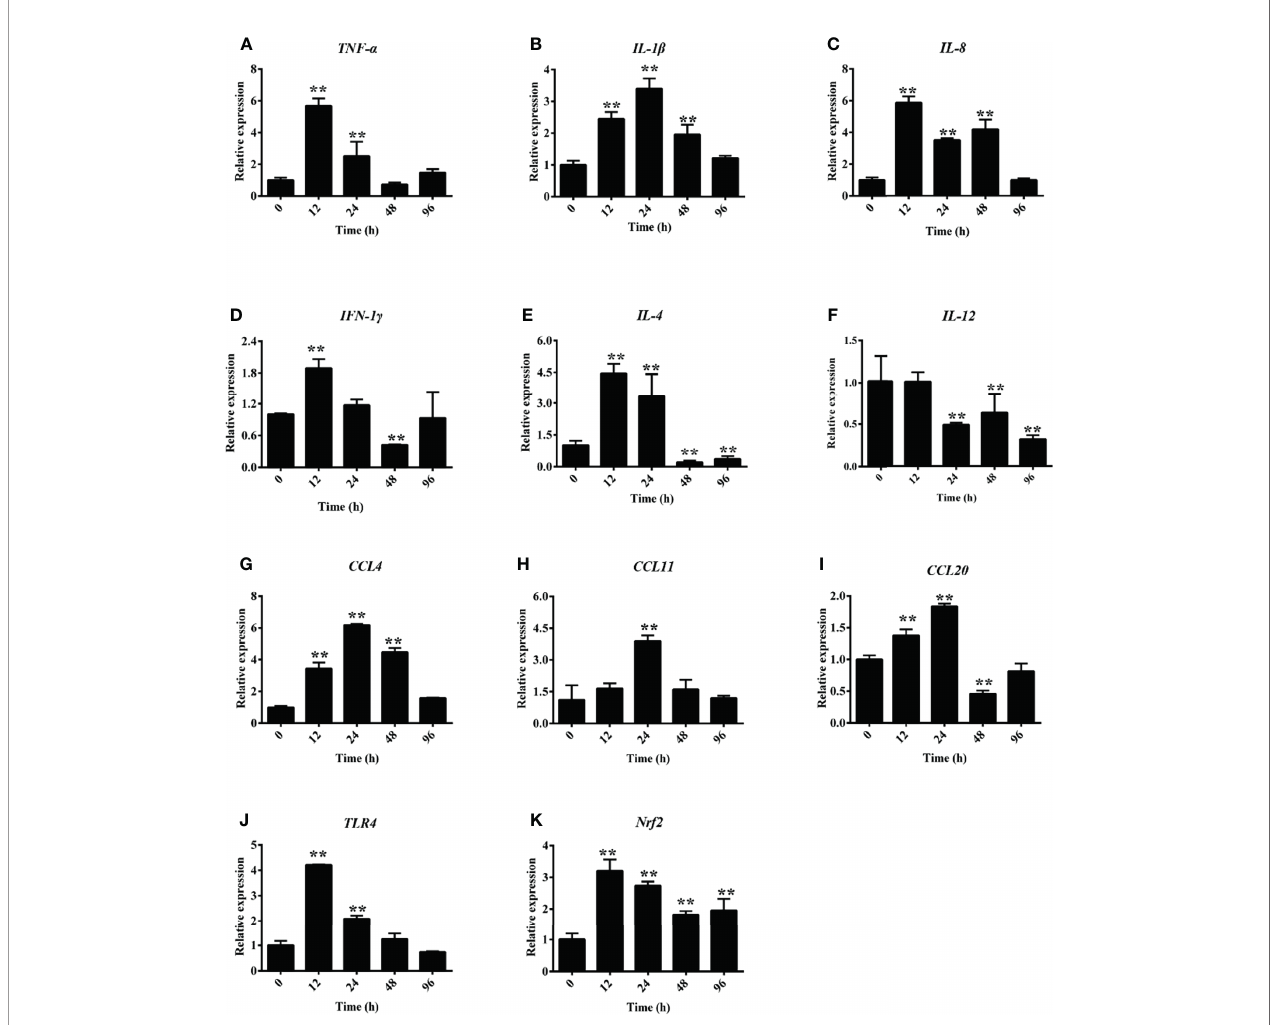
FIGURE 7 | Phenylhydrazine (PHZ)-induced hemolysis caused differential mRNA expression levels of several cytokines measured by qRT-PCR in the head kidney. Cytokines: TNF- a (A) , IL-1 b (B) , IL-8 (C) , IFN-1 g (D) , IL-4 (E) , IL-12 (F) . Chemokines: CCL-4 (G) , CCL-11 (H) , CCL20 (I) , TLR-4 (J) , and Nrf-2 (K) . Data are representative of three independent experiments. ** p < 0.01 (Student ’ s t -test). Data represent the mean ± SD of three independent